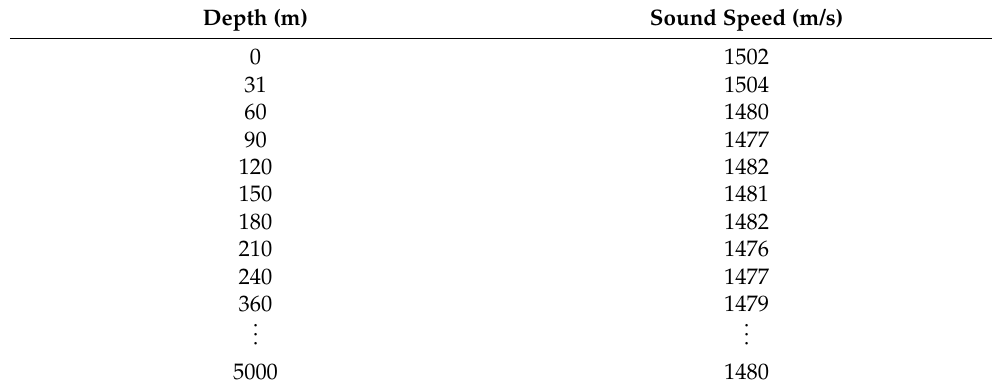
Table 2. The sound velocity profile.